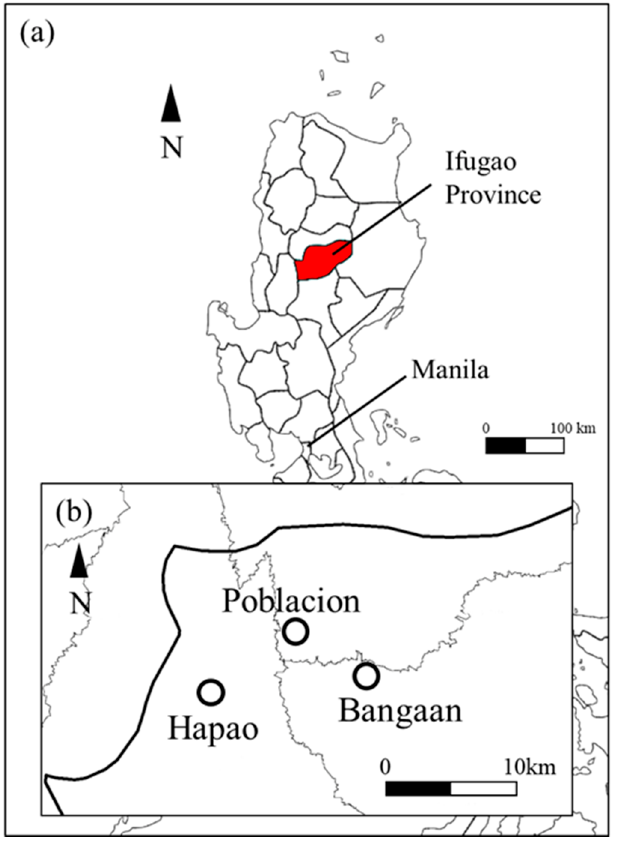
Figure 1. Site map for ( a ) Ifugao province and ( b ) sampling villages.